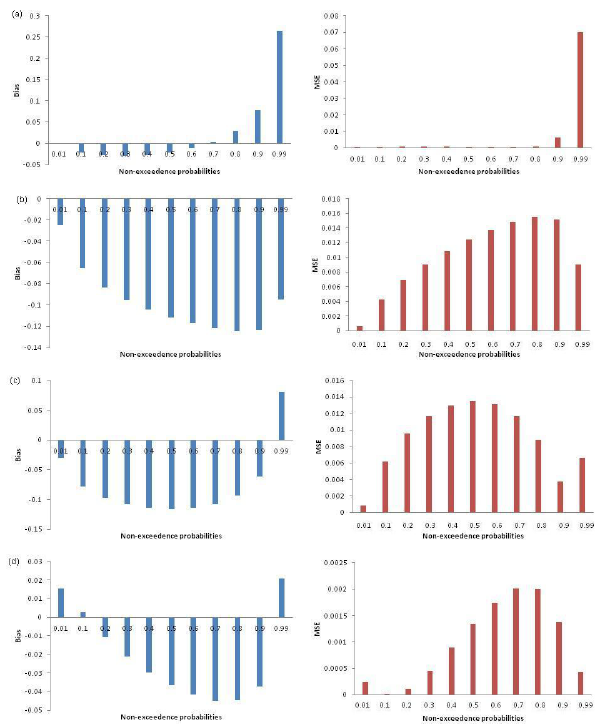
Fig. 5. Bias and MSE for simulated samples for catchments (a) A5040512, (b) A5030502, (c) A5050502 and (d)